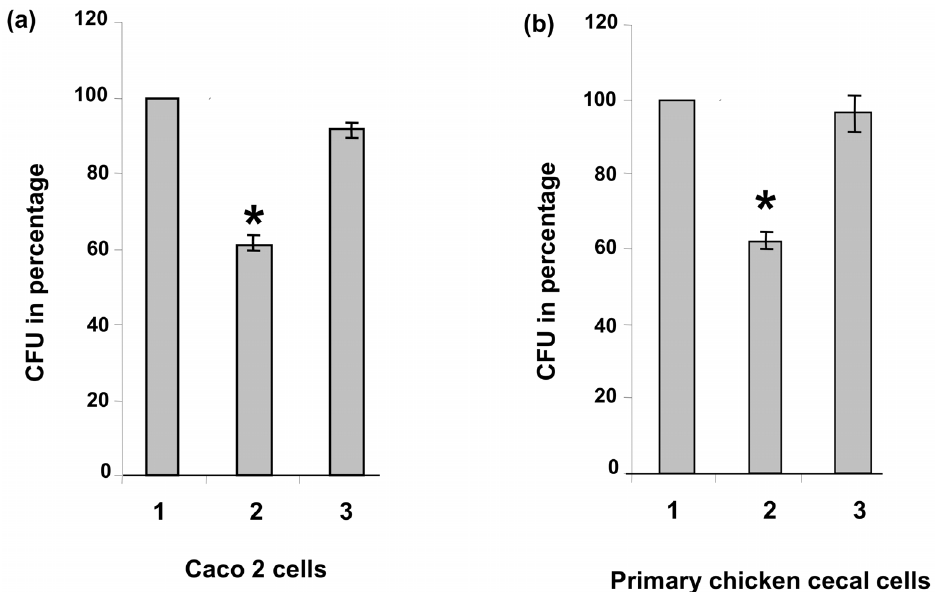
Figure 2. Gentamicin protection assays. 1. wild type strain NCTC 11168, 2. mutant strain NCTC 11168:: cj0268c , 3. complemented mutant NCTC 11168:: cj0268c -comp- cj0268c . Gentamicin protection assays with the strains under investigation using (a) Caco2 cells and (b) PCC-cells. The assays on Caco2 cells with the parental strain, the knockout mutant and the complemented knockout mutant confirmed the infection-deficient phenotype to be due to the functional loss of cj0268c. Four independent experiments have been carried out, respectively. The standard deviations are indicated. (a) Taking the number of C. jejuni wild type strain NCTC 11168 colonies recovered as 100%, the mean value of cj0268c -mutant colonies (NCTC 11168:: cj0268c ) accounted for 62% ( 6 2.41), whereas the percentage of obtained colonies from the complemented strain (NCTC 11168:: cj0268c -comp- cj0268c) was 93% ( 6 2.04). Since the P -value for the mutant was less than 0.001, the reduced invasion capacity was significant. (b) The relevance of cj0268c for invasion is not restricted to human cells, since it could also be shown for the invasion of PCC-cells. Compared to the invasion capacity of parental strain NCTC 11168 (100%), the percentage of colonies obtained from mutant strain NCTC 11168:: cj0268c was only 62% ( 6 2.36, P , 0.0007). However, complementation of the mutant strain with cj0268c restored the infectivity of NCTC 11168:: cj0268c -comp- cj0268c which was similar to that of the parental strain (96%, 6 4.96).